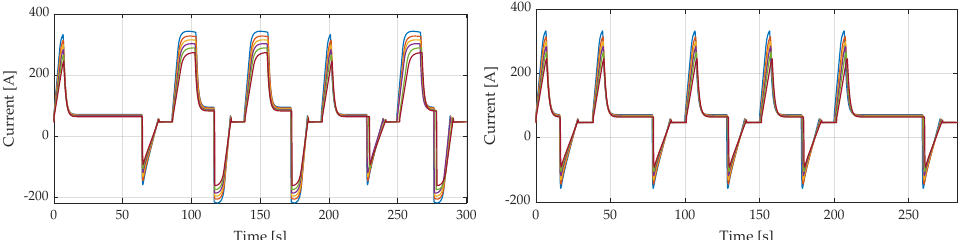
Figure 16. Current of conventional trolleybuses according to the vehicle’s weight covering the outgoing ( left ) and return ( right ) journeys of line 14. The weights start at 30 t (upper blue line) and decrease to 20 t (bottom red line) with 2 t steps.